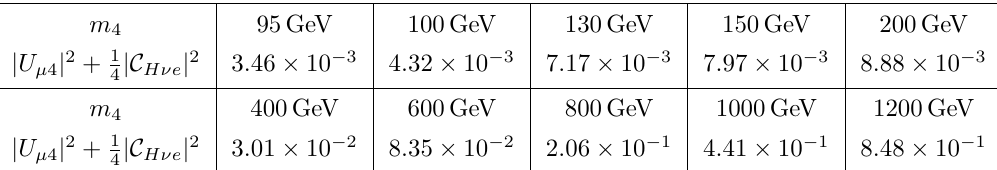
Table 3 . Limits on d = 6 coupling C Hνe = v 2